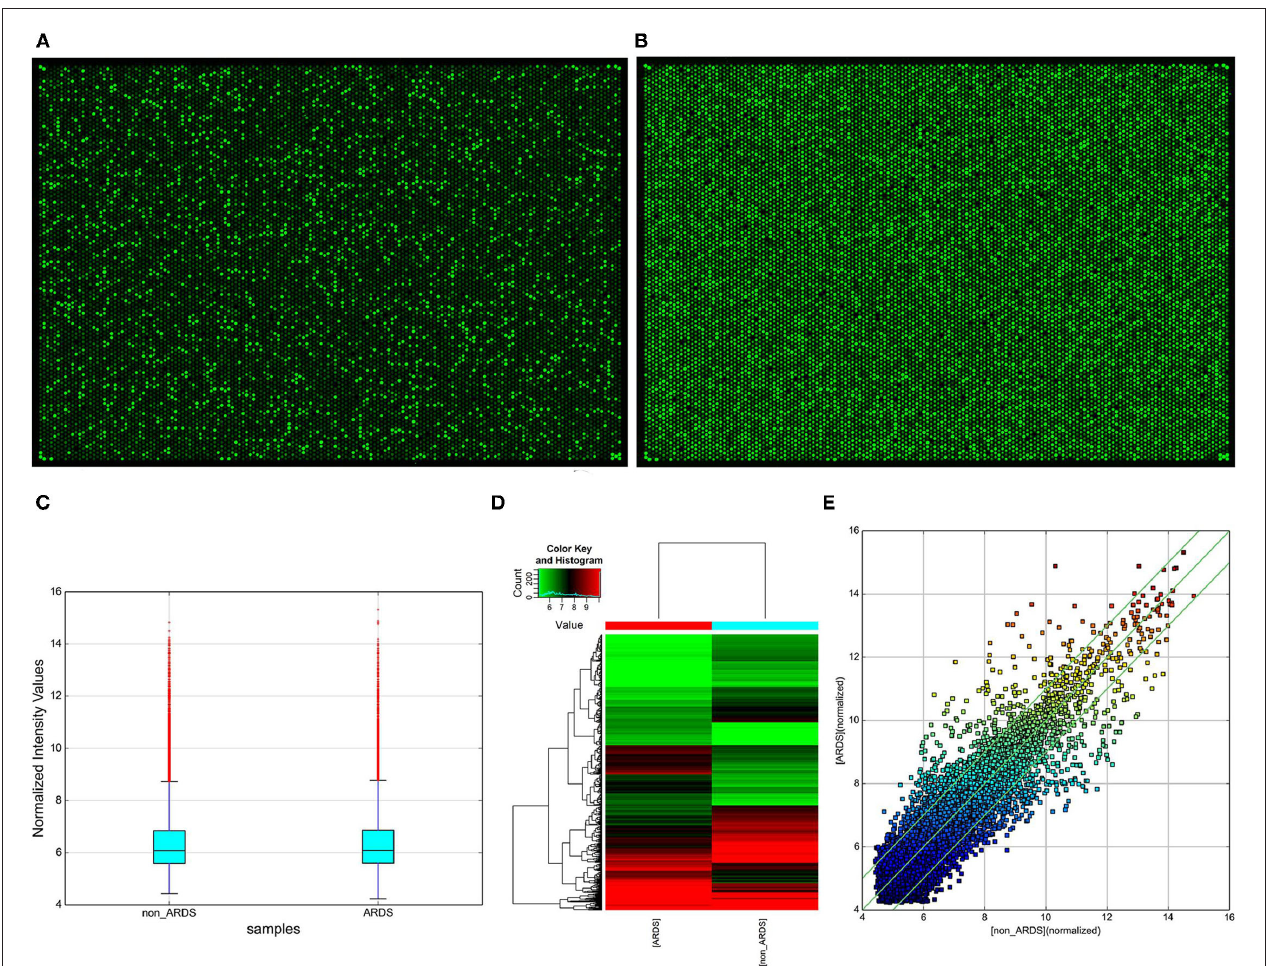
FIGURE 2 | Identification of differentially expressed circRNAs. (A) High-throughput human circRNA microarray-array image of NARDS. (B) High-throughput human circRNA microarray-array image of non-NARDS. (C) Box plot, a method of describing data in terms of minimum, first quartile (25%), median (50%), third quartile (75%), and maximum. The abscissa is the sample name, and the ordinate is the value of the signal value of the probe after log2. The upper and lower sides of the rectangular box correspond to the upper and lower quartiles of the data (Q1 and Q3). The median line inside the rectangular box is the median, the upper line is the Q1 + 1.5 interquantile range (IQR), and the underline is Q3–1.5 IQR, where IQR is the middle quartile range, IQR = Q3–Q1. (D) Hierarchical clustering analysis arranges samples into groups based on their expression levels, which allows us to hypothesize about the relationships among samples. Hierarchical clustering was performed based on all circRNAs from two different samples. The result of hierarchical clustering shows a distinguishable circRNA expression profiling between samples. (E) Scatter plot, the values of the X and Y axes in the scatter plot are the normalized signal values of the samples (log2 scaled) or the averaged normalized signal values of groups of samples (log2 scaled). The green lines are fold change lines. The circRNAs above the top green line and below the bottom green line indicated more than 2.0-fold change of circRNAs between the two compared samples, circRNAs, circular